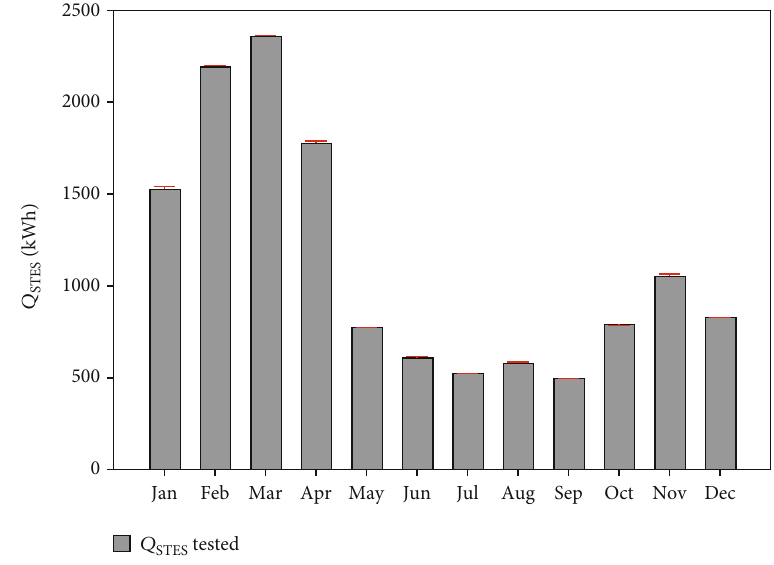
Figure 7: Comparison between Q